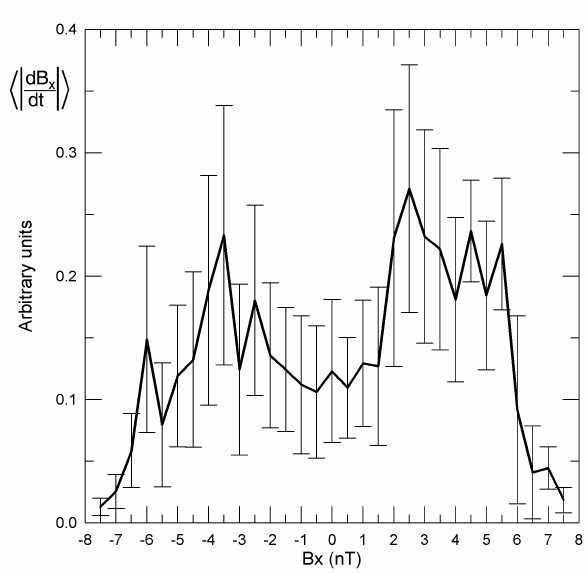
Fig. 3 as a function of B x . Vertical bars show r.m.s.